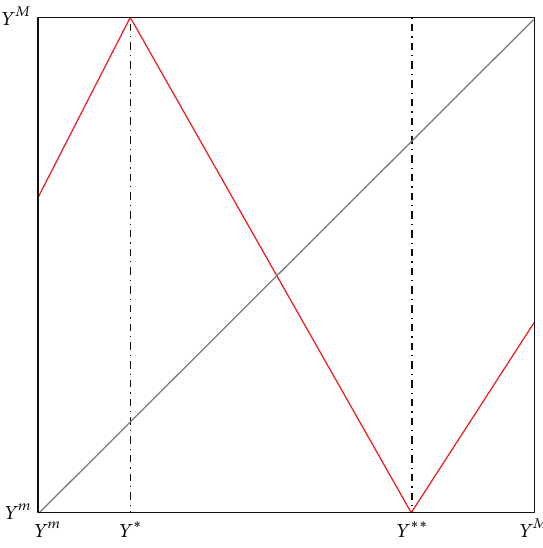
Figure 1: The function 𝐹(𝑌) in the trapping interval [𝑌 𝑚 , 𝑌 𝑀 ] .